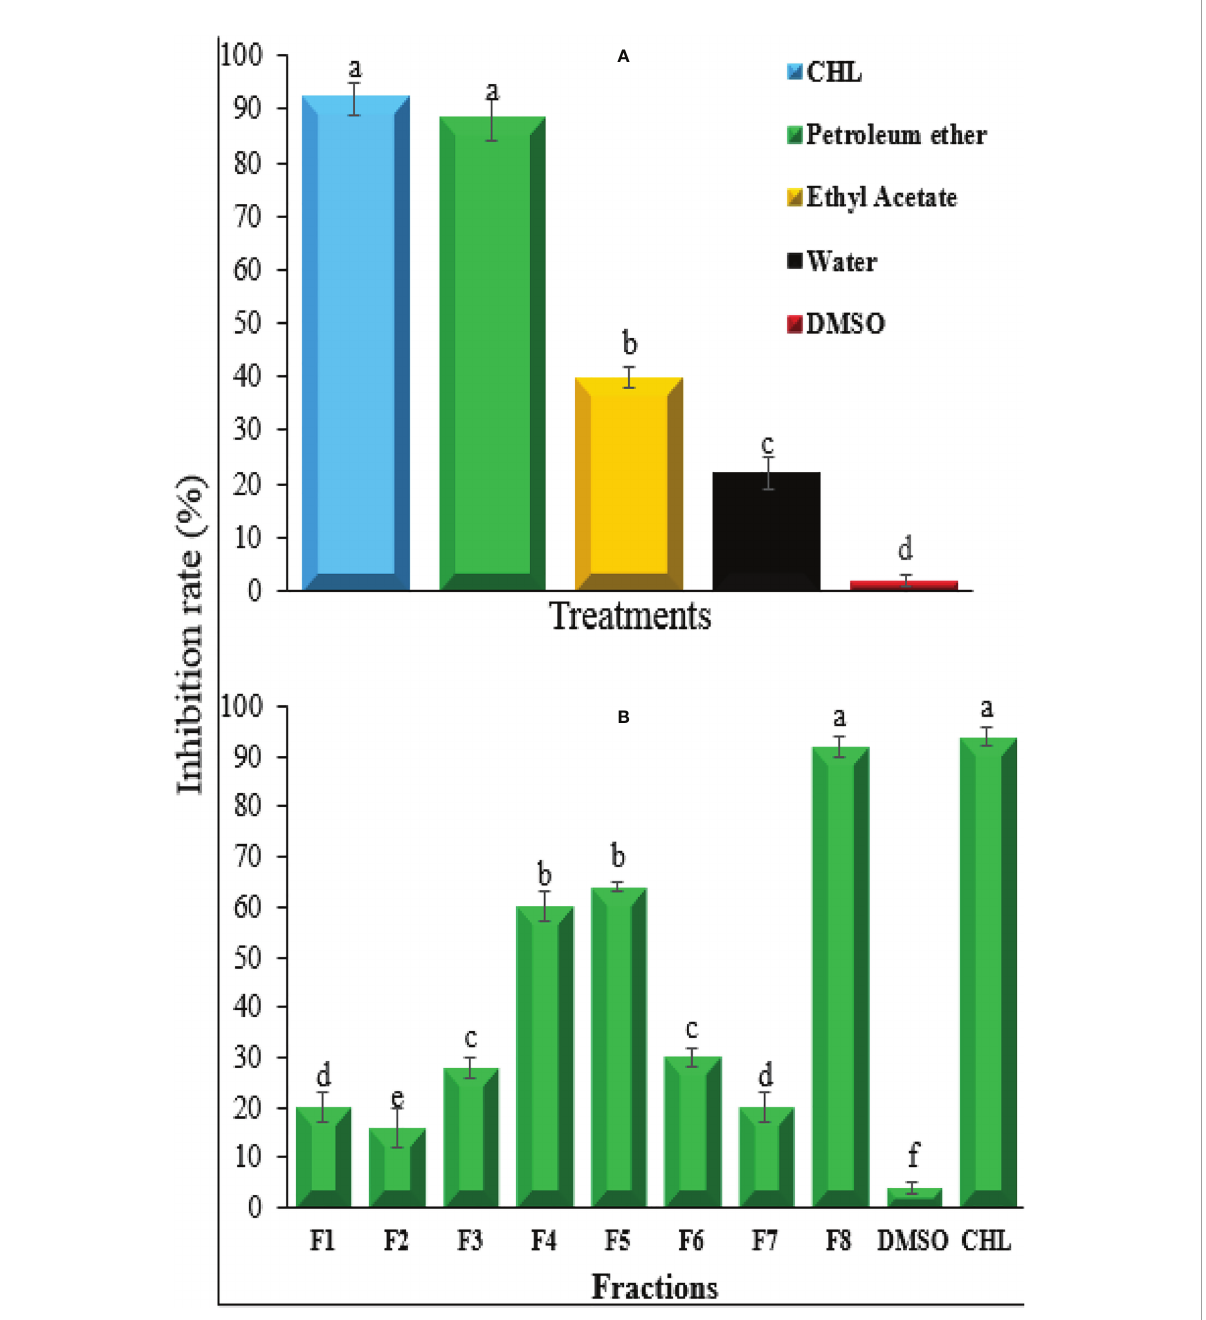
FIGURE 2 Growth inhibition rate of (A) niger extract using different solvents (A) and different fractions of petroleum ether extract (B) against bacterial wilt pathogen Ralstonia solanacearum . CHL, chloramphenicol; DMSO, dimethyl sulfoxide. Bars represent the standard error. Lower case lettering shows the signi fi cant difference among the